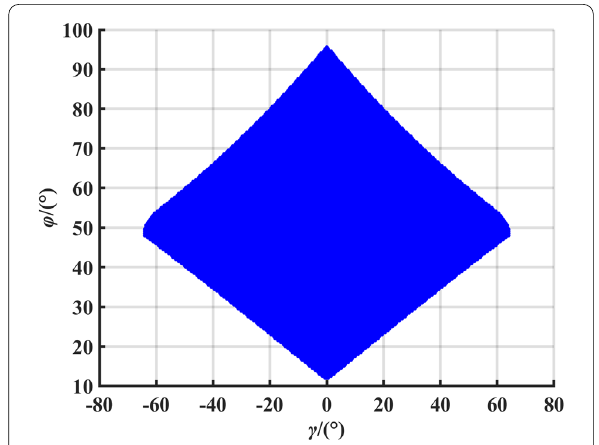
Figure 6 Workspace of the spherical mechanism